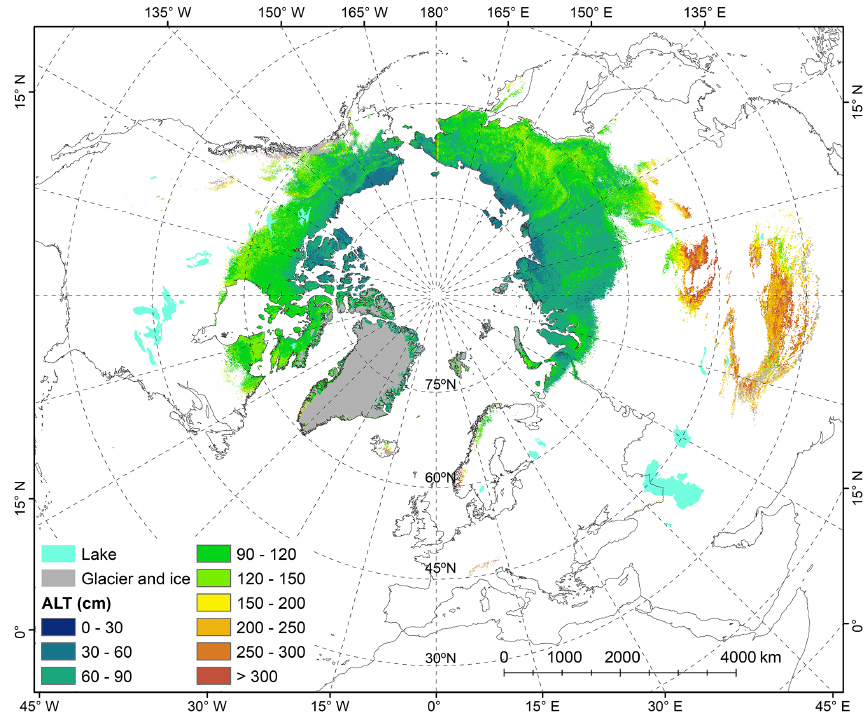
Figure 4. Distribution of the average active layer thickness (ALT) in the Northern Hemisphere for the period of